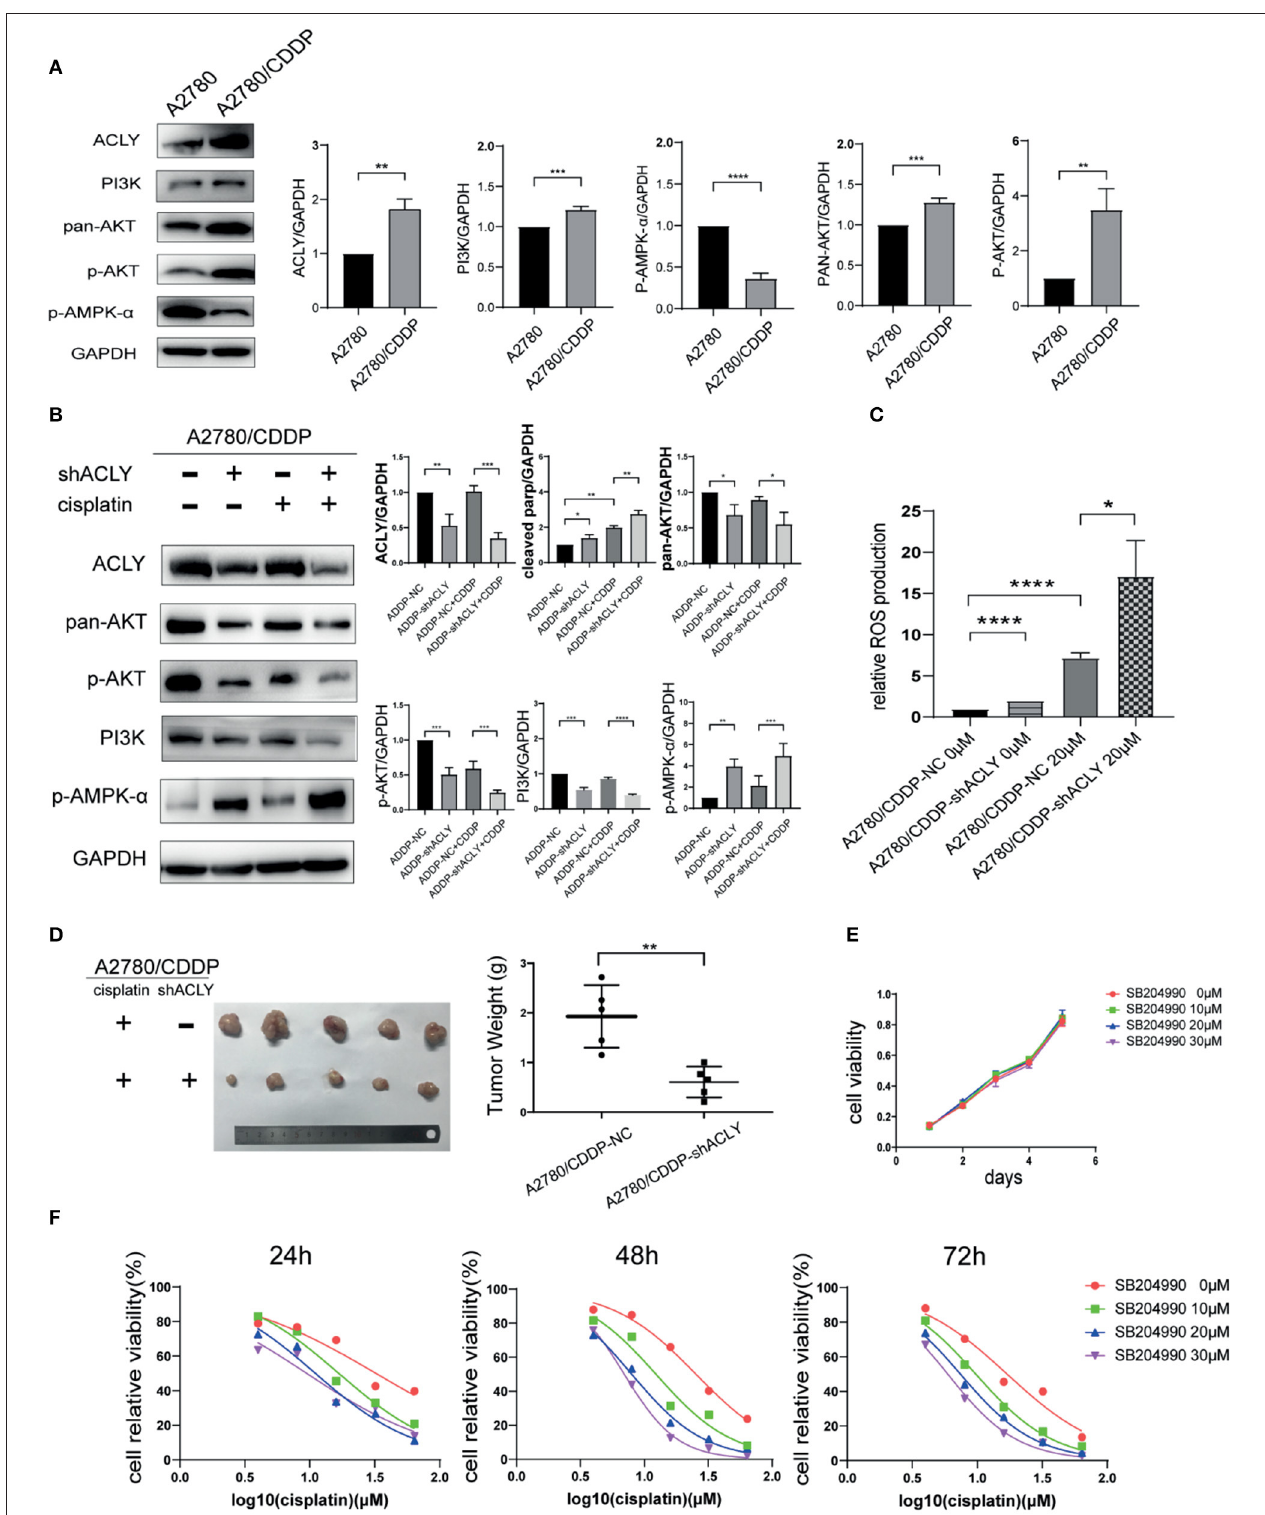
FIGURE 5 | ACLY knockdown inhibited PI3K/AKT pathway and activated AMPK pathway. (A) Western blotting was used to detect the differential expression of ACLY, PI3K/AKT pathway and p-AMPK- α in A2780 and A2780/CDDP cells. (B) Western blotting on A2780/CDDP-NC and A2780/CDDP-shACLY cells, and them under